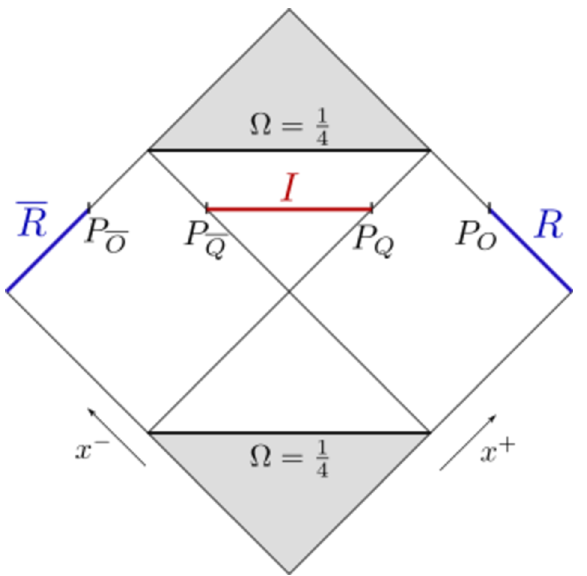
Figure 7 . Island in the eternal black hole. With the radiation collected on I + , the endpoints of the island are on the